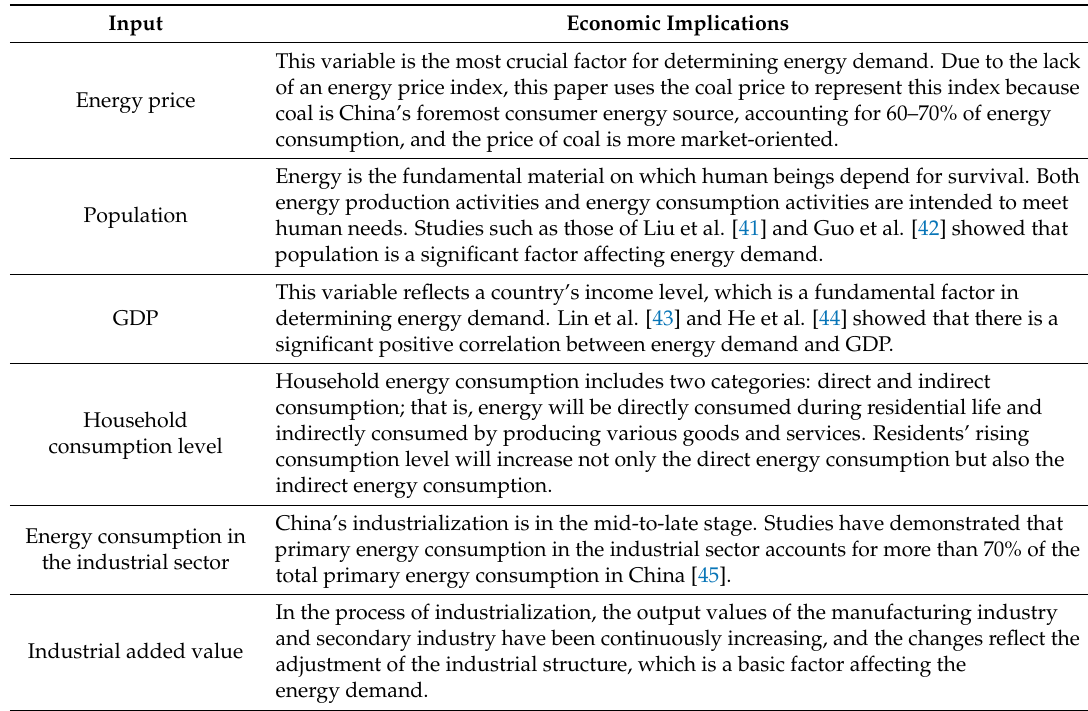
Table 2. The variables of the input